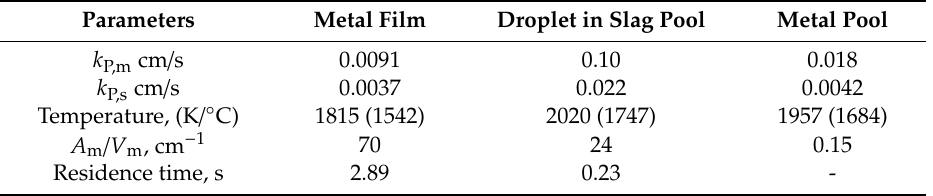
Table 4. The related parameters used in the